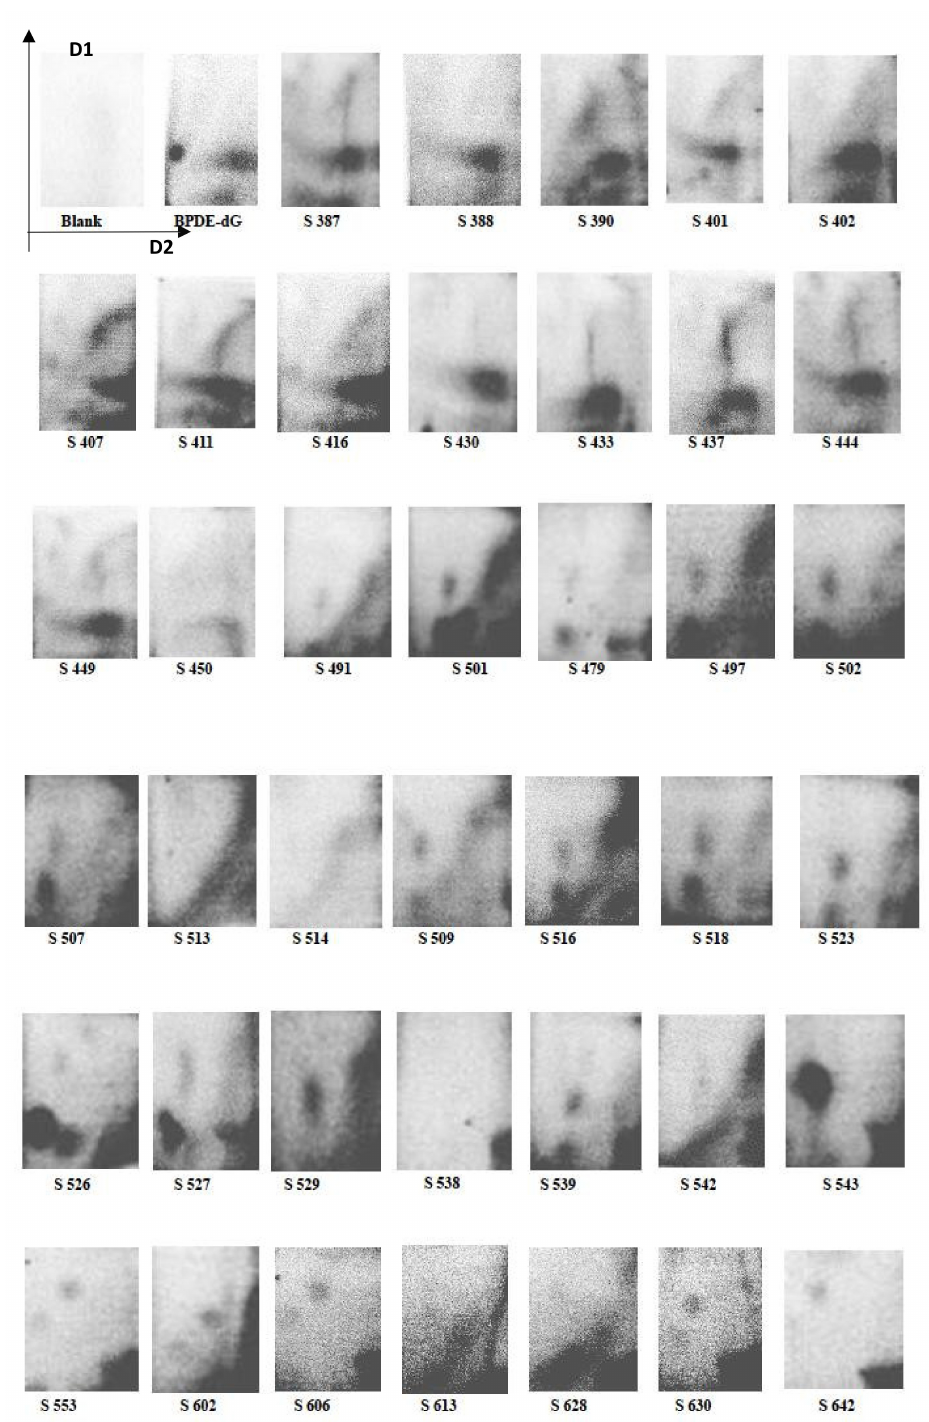
Figure 1. Examples of autoradiographic patterns of DNA adducts as detected by 32P post-labelling in thin layer chromatography sheets. The origin of the multidirectional chromatography was located in the left bottom corner of the sheet. Blank, DNA free negative control samples; BPDE-dG, reference positive standard; S387–S642 samples codes. A variety of DNA adduct patterns were detected including barely detectable single spots (e.g., S642), multiple spots either weak (e.g., S553) or strong (e.g., S526), diagonal radioactive zone (e.g., S516), multiple spots and diagonal radioactive zone (e.g., S516), negative samples (e.g.,